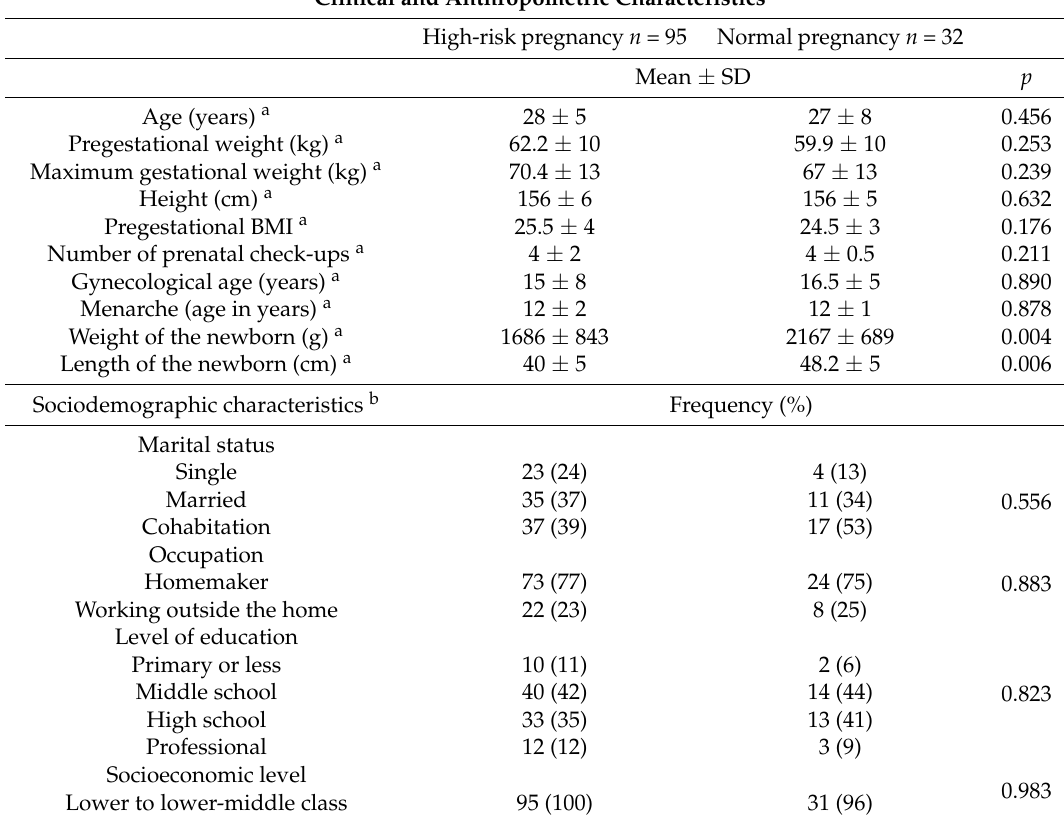
Table 1. Clinical, anthropometric and sociodemographic characteristics of the mothers and newborns ( n =